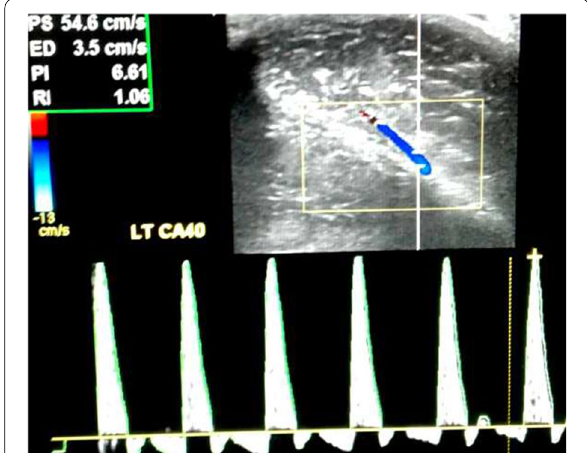
Fig. 1 Spectral waveform of the left cavernosal artery of a patient at 40 min showing normal arterial inflow with PSV of 54.6 cm/s, holo-diastolic flow reversal and good venous